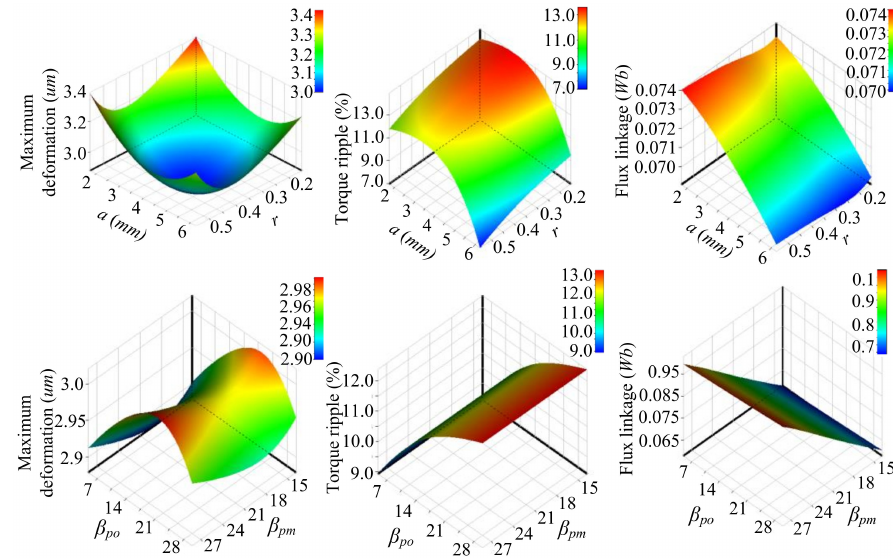
Figure 8. Response surface analysis of di ff erent optimization objectives versus design